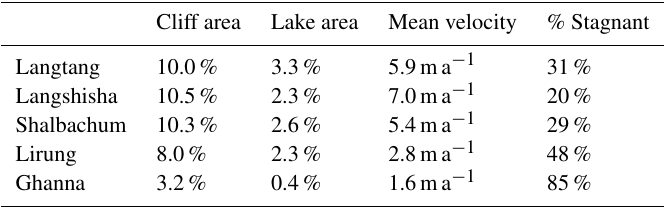
Cliff and lake area corresponds to the percentage of 30m pixels containing cliffs/lakes (median of six available cliff and lake maps from the period 2006–2015). Mean velocity is calculated